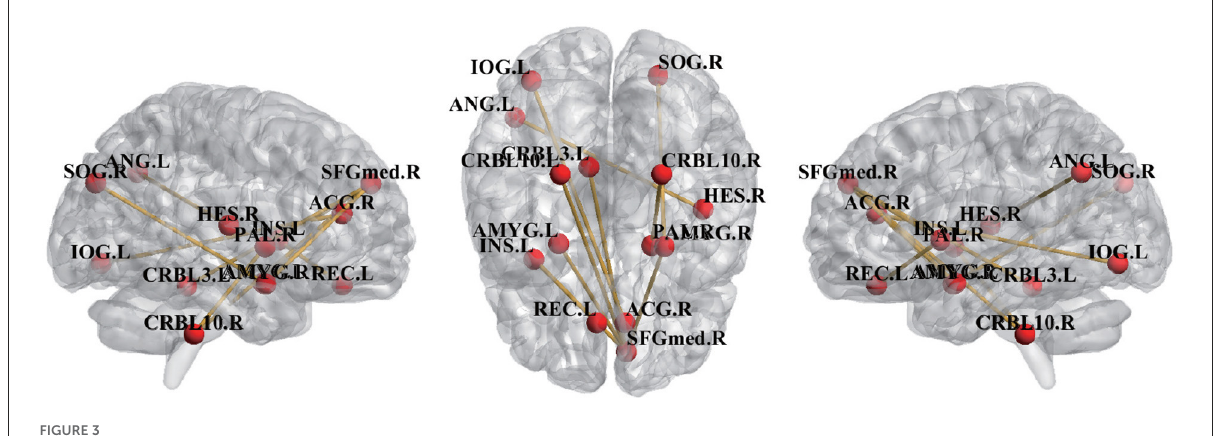
FIGURE3 Top 10 pairwised ROIs identified by the proposed